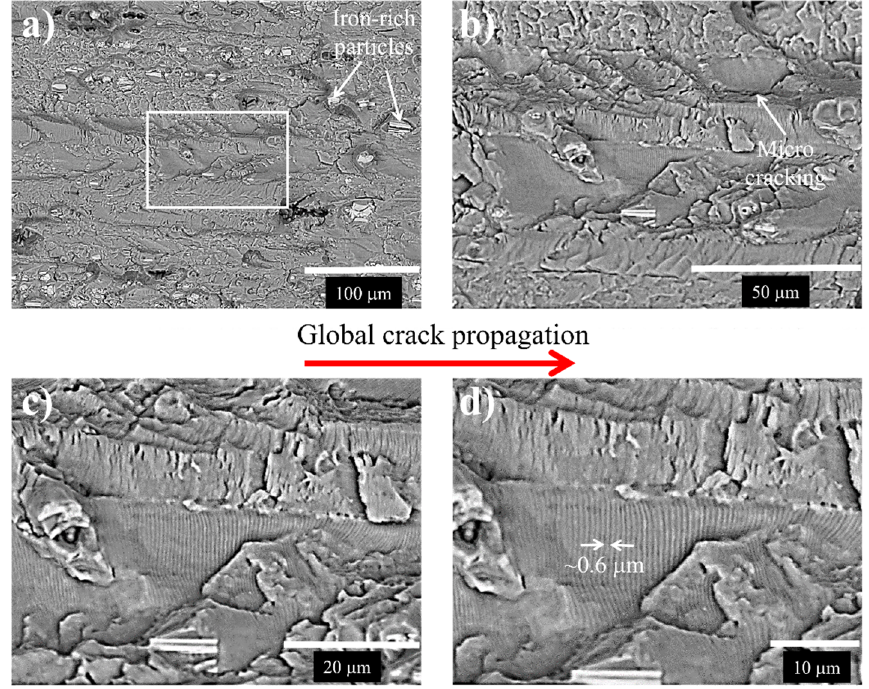
Figure 13. Fracture surface of the 7075-T651 aluminum alloy (base material non-LCD), ( a ) image taken at lower magnification showing Fe-rich particles, ( b – d ) details of the rectangle marked in ( a ) at higher magnifications.